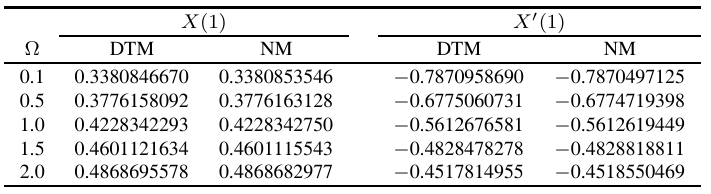
Table 6 The comparison between the Numerical and DTM solution of X (1) and X (cid:3) (1) for